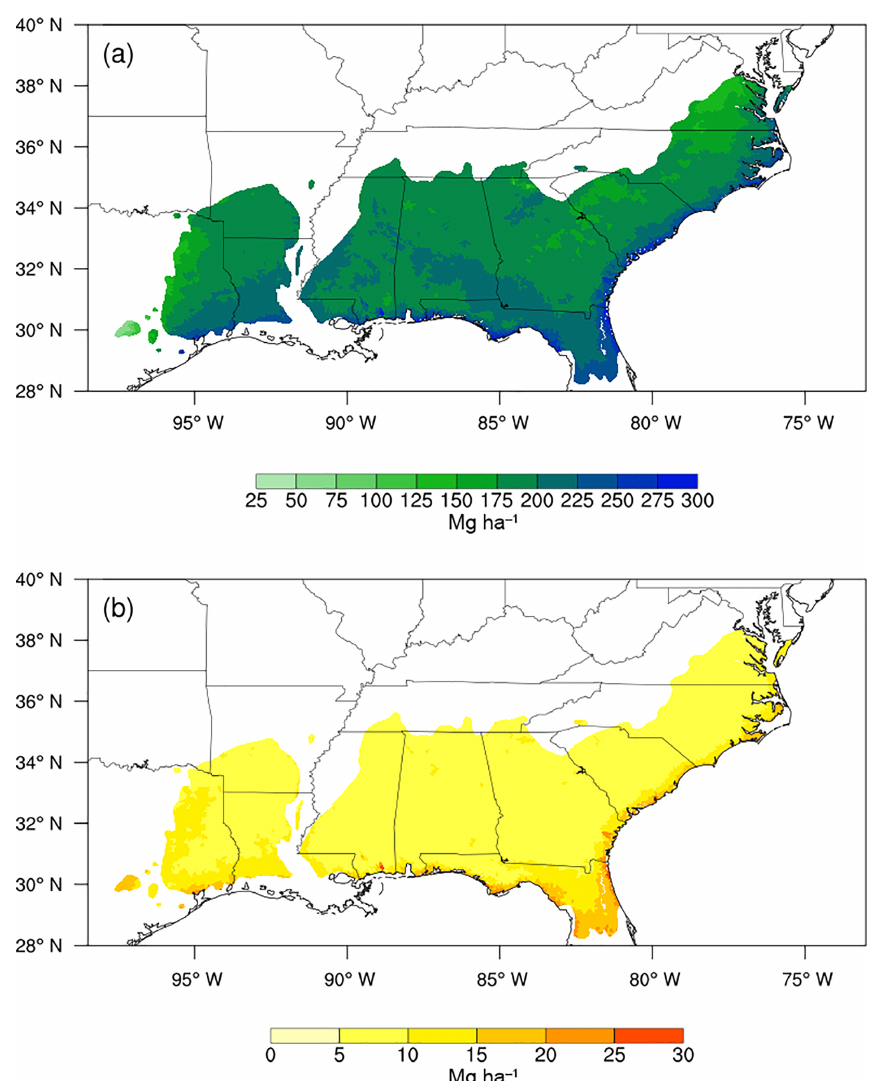
Figure 7. (a) Regional predictions of stem biomass stocks for a 25-year-old stand planted in 1985. Parameters used in the predictions were from the Base assimilation approach described in Table 5. (b) The width of the 95% quantile interval associated with uncertainty in model